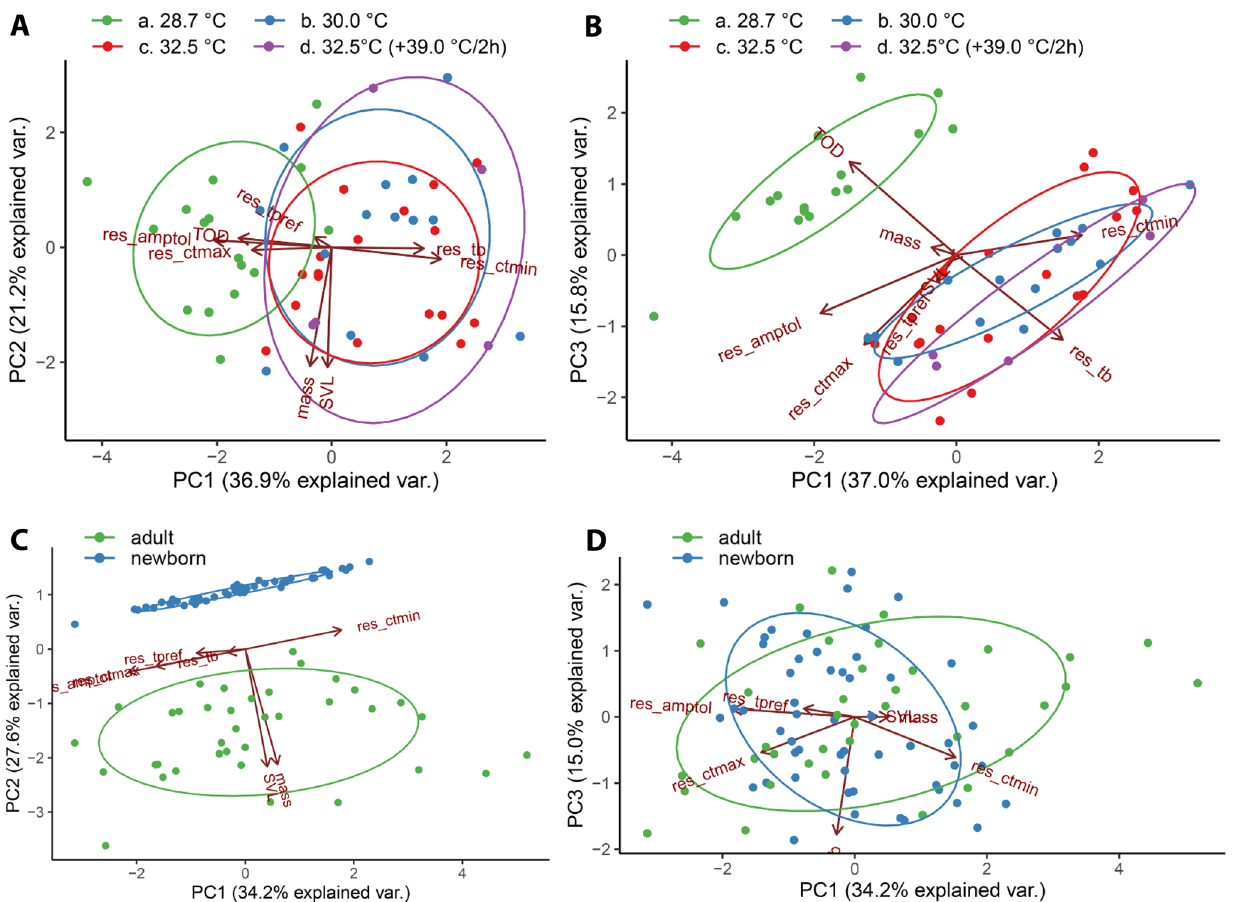
Figure 3. Principal component analysis biplot for incubation temperature and age effects over thermal physiological traits of Tropidurus torquatus. A-B, variation in incubation temperature effect at PC1 versus PC2 ( A ) and PC1 versus PC3 ( B ). C–D, variation in and age effect at PC1 versus PC2 ( C ) and PC1 versus PC3 ( D ). Abbreviations: explained var., explained variance; Mass, body mass; res_amptol, thermal-tolerance range residuals; res_ctmax, critical thermal maximum residuals; res_ctmin, critical thermal minimum residuals; res_ tb, basal body temperature residuals; SVL, Snout-vent length; TOD, time of development (days).